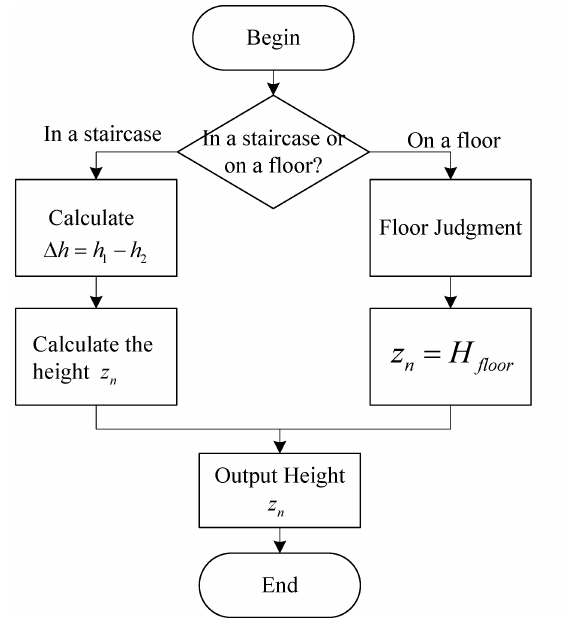
Figure 7. Flow chart of the height calculation.